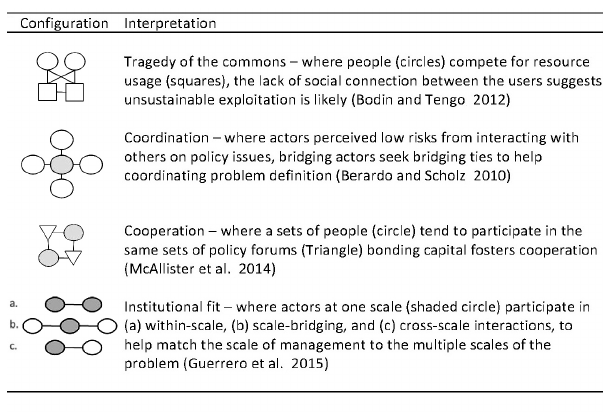
Fig. 3 . Examples where broader theoretical ideas have been linked subnetwork configurations.